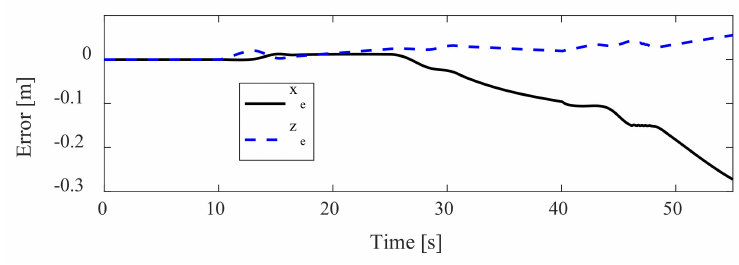
Figure 9. The position error of end effector without vehicle control.